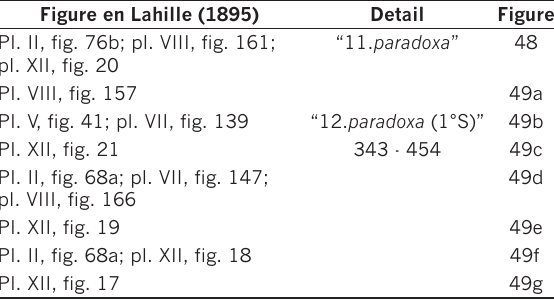
Table 19. Voluta paradoxa typica , specimens figured by Lahille (1895) with the detail of the inscriptions on their shells and fig - ures